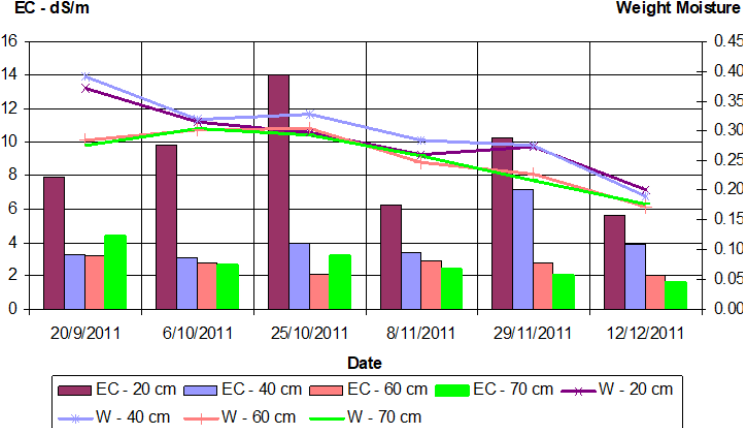
Figure 7. Changes in soil salinity (EC) and soil weight moisture (W) during the autumn near the second tensiometer station.